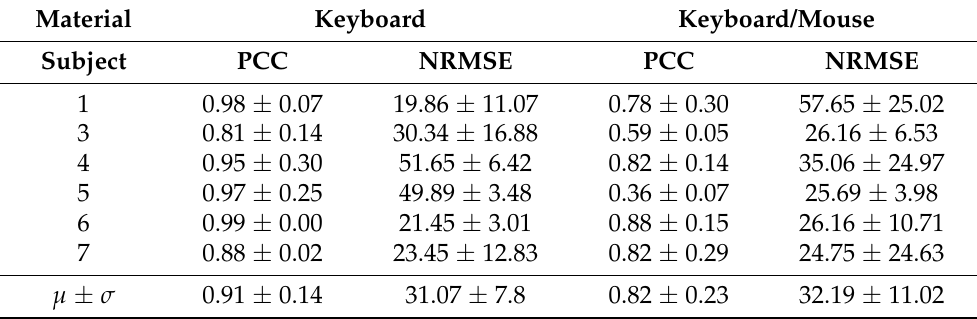
Figure 5. Example heartbeat waveforms for a randomly selected subject, obtained using the electrode materials: ( A ) Keyboard; and ( B ) Keyboard/Mouse. Table 4. Pearson correlation coefficient (PCC) and Normalized Root-mean-square error (NRMSE) between the heartbeat waveforms of ECG REF and ECG